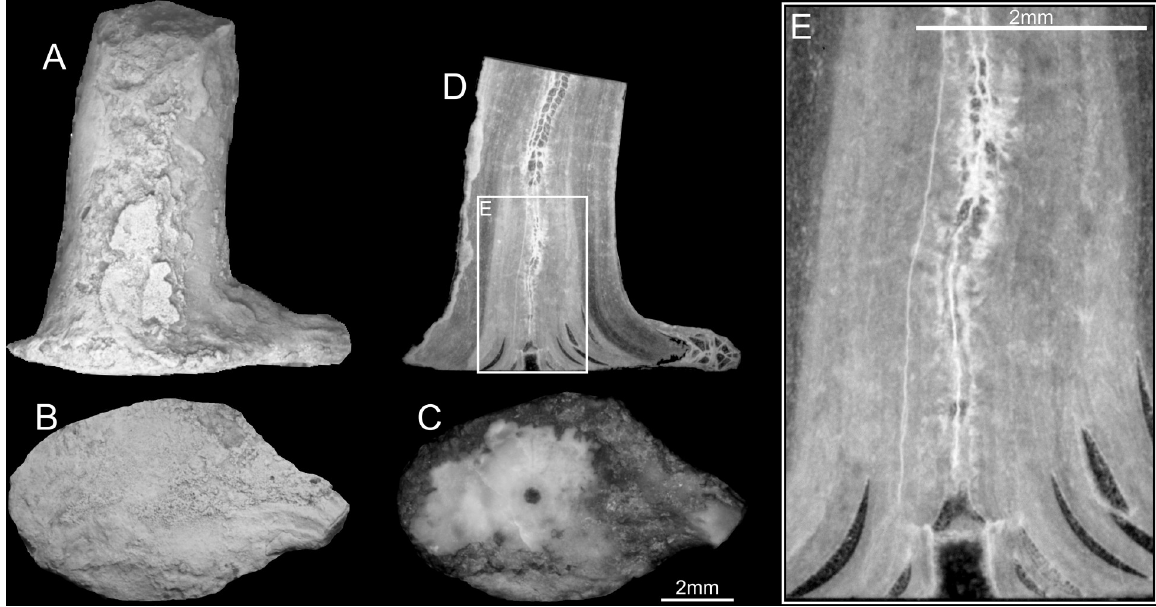
Fig 4. Oligophylloides sp.—Juvenile specimen UAM/He/B/017. A, B–external view (side and bottom); C–partly ground bottom of the attachment body (note the empty hole in the centre); D–longitudinal thin section of the specimen trough the central lumen of the protobranch; E–enlarged fragment of the lower part of the longitudinal section (D). Scale bar 2